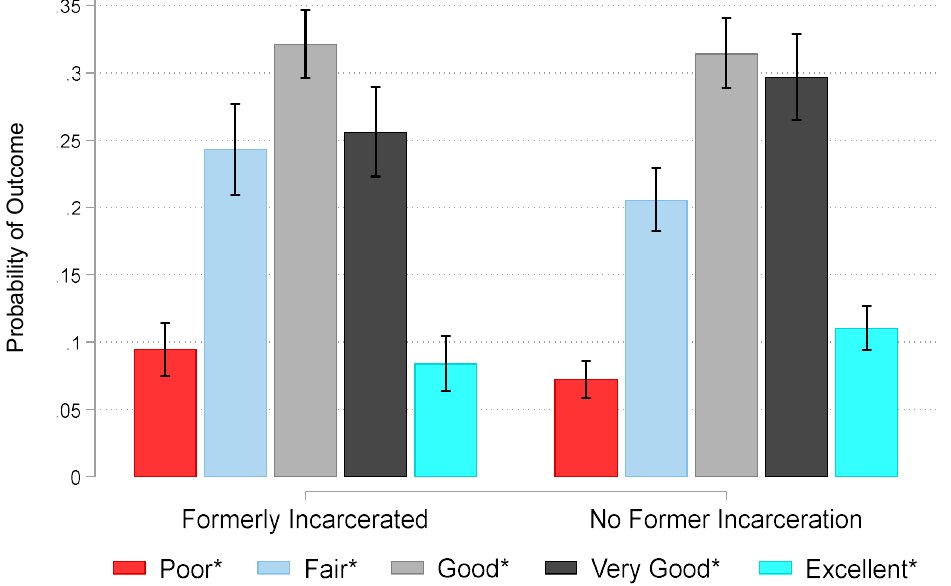
Figure 2. Predictions of Oral Health among African American Men in the National Survey of American Life, 2003. Note : Fully-adjusted estimates generated from Model 3 in Table 2 (n = 1166). Probabilities of poor, fair, and good health are significantly higher for formerly incarcerated men. Probabilities of very good and excellent health are significantly lower for formerly incarcerated men. * Probabilities of an outcome are significantly different for formerly and never incarcerated men at p < 0.05.